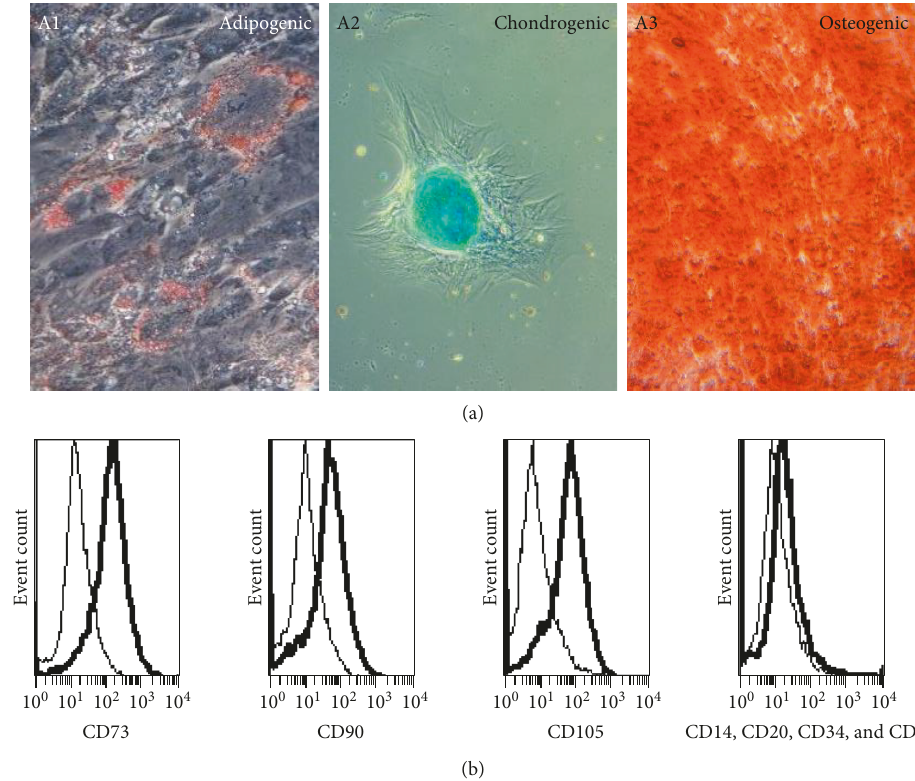
Figure 2: In vitro di ff erentiation potential and immunophenotype of AF-MSCs. Multilineage di ff erentiation potential of AF-MSCs was investigated by applying adipocyte, chondrocyte, and osteoblast di ff erentiation media to the cells for 3 weeks. Staining of Oil Red O showed successful di ff erentiation into adipogenic lineage with developed fat vacuoles surrounding the cell nucleus (A1). Chondrogenic di ff erentiation was shown to be present by alcian blue staining of cell aggregates containing proteoglycan (A2). Osteoblast formation by AF-MSCs was indicated by alizarin red S staining of calcium deposits (A3). Flow cytometry was used for the analysis of cell surface marker expression. Histograms showed that MSC markers CD73, CD90, and CD105 were detected as cell surface proteins on AF-MSCs preparation derived from C-sections whereas hematopoietic marker expressions CD14, CD20, CD34, and CD45 were low (bold lines) (b). Antibody isotype controls are represented by thin